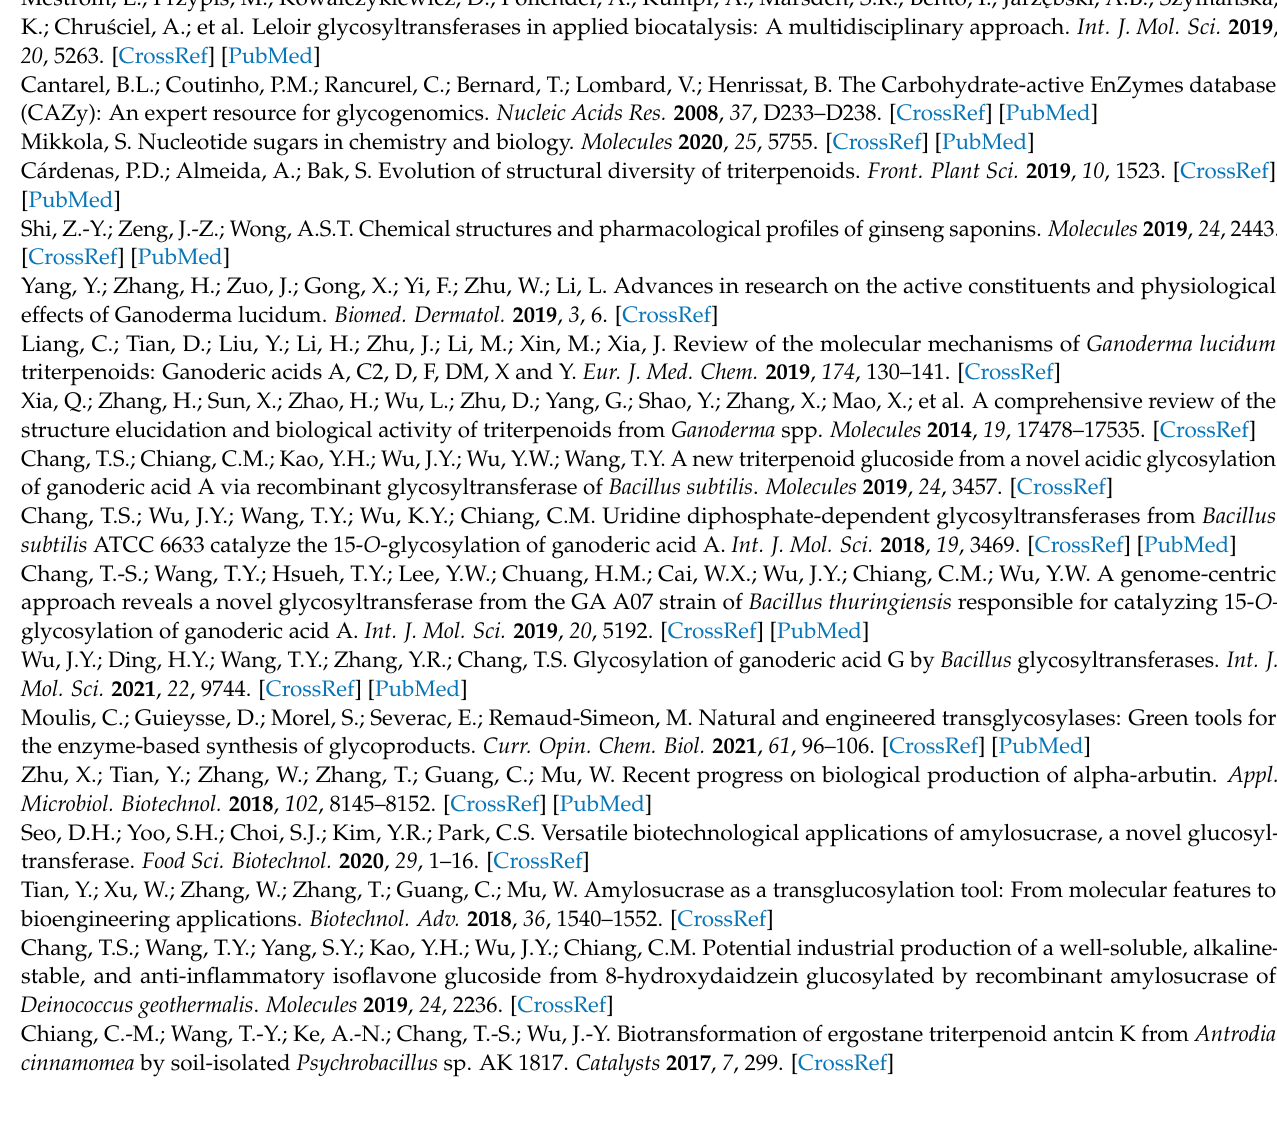
Figure S24. 2D NMR spectrum ( 1 H- 13 C HMBC, 700 MHz, pyridine- d 5 ) of the compound ( 3 ). Figure S25. 2D NMR spectrum ( 1 H- 1 H COSY, 700 MHz, pyridine- d 5 ) of the compound ( 3 ). Figure S26. 2D NMR spectrum ( 1 H- 1 H NOESY, 700 MHz, pyridine- d 5 ) of the compound ( 3